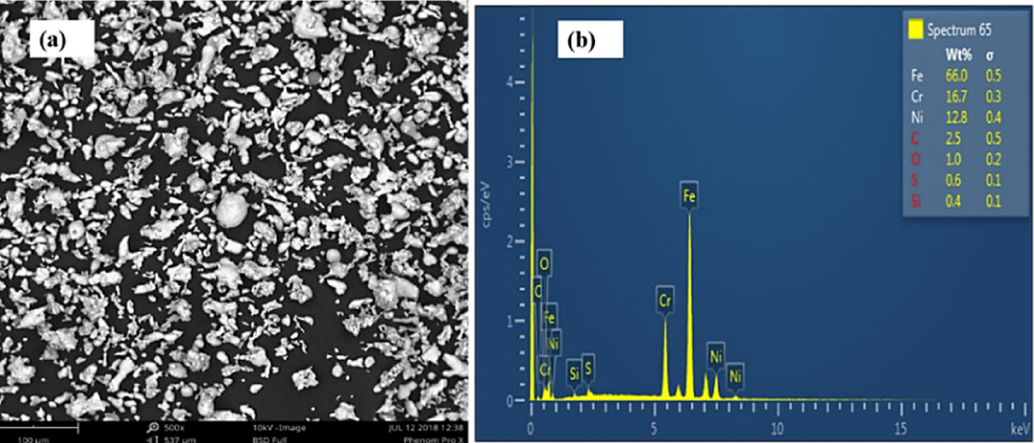
Figure 1. SEM (a) and EDX (b) of 316L stainless steel powder.